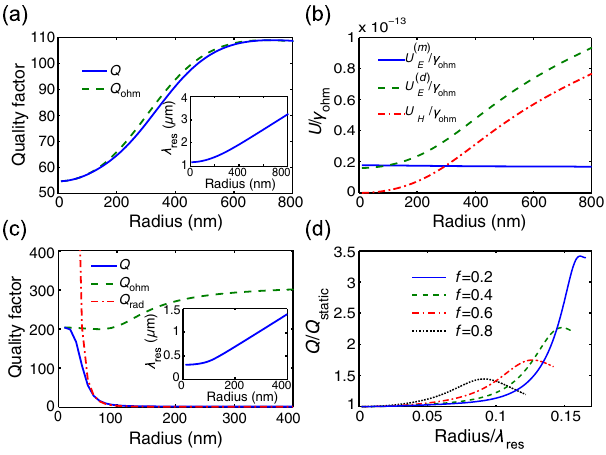
FIG. 3. (a) Q (solid line) and Q (dashed line) of a ohm quadrupolar resonance ( l ¼ 2 ) supported by a hyperbolic cavity with five functional pairs. The inset shows the resonant wave- length as the cavity radius R increases. (b) Distribution of the electromagnetic energy divided by the Ohmic damping as the ð m Þ cavity radius R increases. Electric energy in metal U , electric E ð d Þ energy in dielectric U , and magnetic energy U are calculated H E from the quadrupolar eigenmode supported by a cavity with five functional pairs. (c) Q , Q , and Q are calculated from the ohm rad quadrupolar eigenmode supported by a solid silver nanoparticle. The inset shows the resonant wavelength as the particle radius increases. (d) Enhancement factors compared with the electro- static limit ( Q=Q ) with different filling ratios of the hyper- static bolic medium. The Q factors are calculated from dipolar eigenmodes supported by cavities with five functional form of electric energy. In addition, the electric energy inside the dielectric region is less than that in the metallic region, which is consistent with the electrostatic prediction [15]. As the particle size increases, the energy stored in the magnetic field increases significantly, representing the